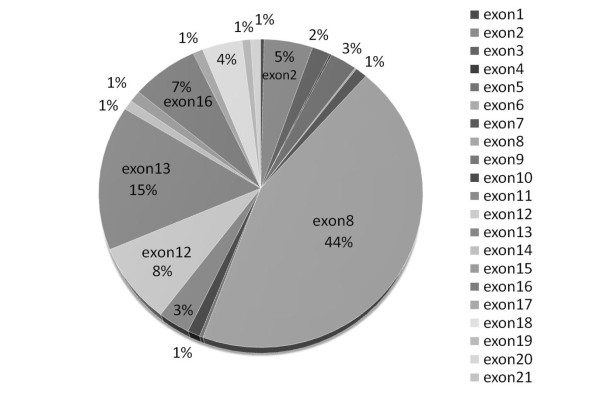
Distribution and frequency of ATP7B gene mutations from 345 patients with Wilson's disease in the Chinese population (including in this study).